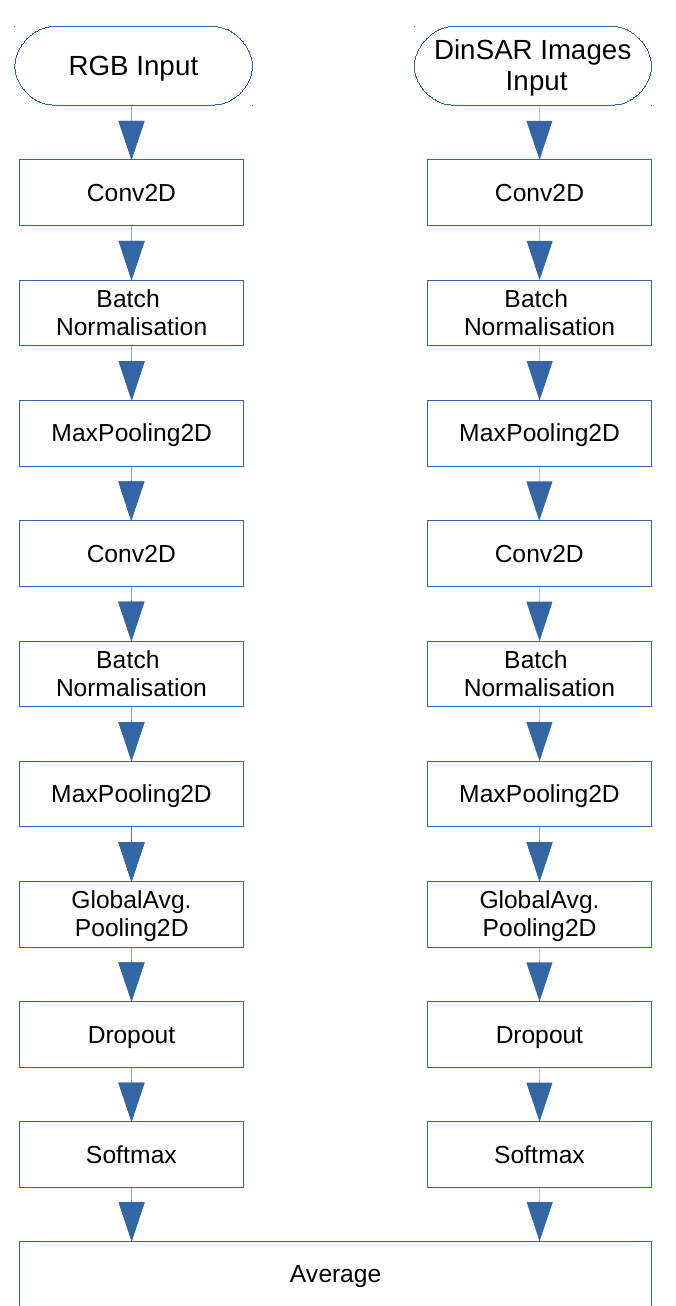
Figure 1. Architecture of ConvNet2, a 2-layer CNN